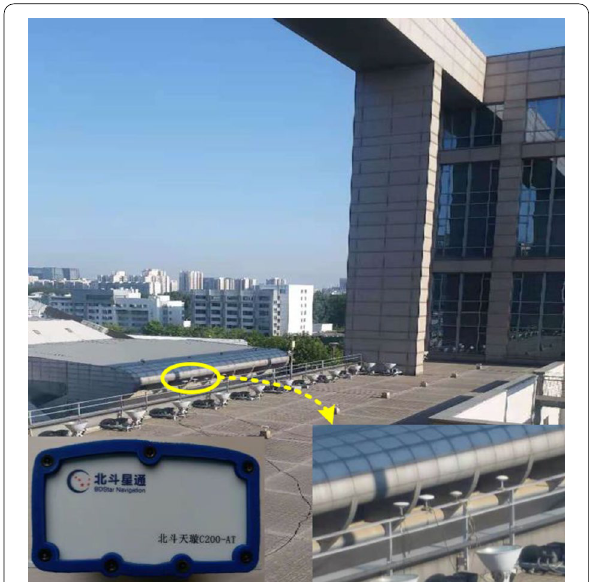
Fig. 3 Sounding environment where the receiver antenna is located